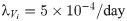
The tumor volume at week 24 for different pair of (γV, γA).Here λVi=5×10−4/day, λDV = 5.2 × 1010 cm3/g ⋅ day, γV = 1 × 10−7−4 × 10−7 g/cm3 and γA = 0.6 × 10−8−9 × 10−8 g/cm3. All other parameter values are the same as in Tables 2 and 3.